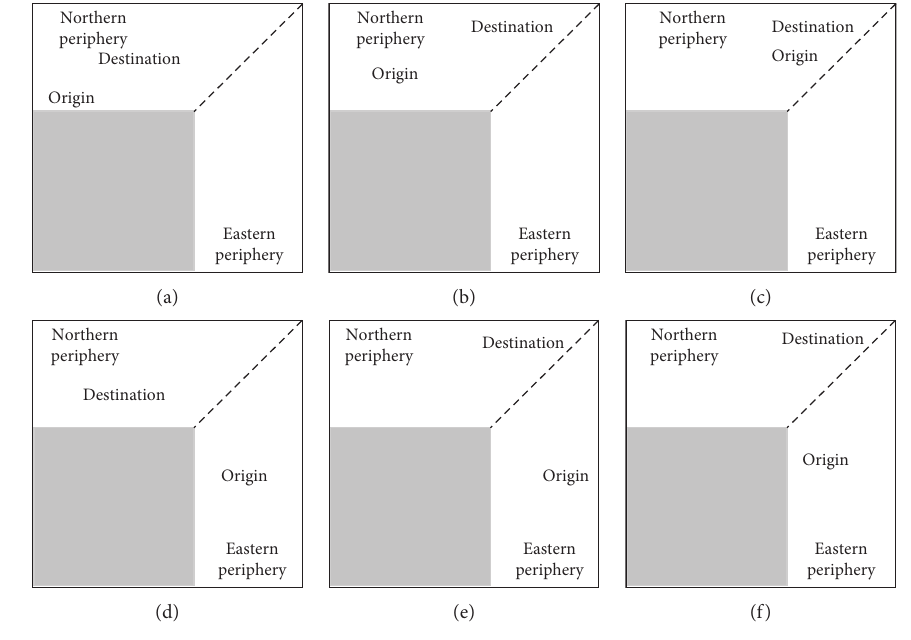
Figure 4: Different situations for case (b).